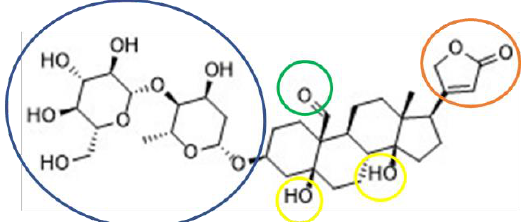
Figure 3. Functional groups in erysimoside: hydroxyl at 5 and 14 (in yellow); oxo at 19 (in green); β - D -glucopyranosyl-(1- > 4)-2,6-dideoxy-4- O- β - D -ribo-hexopyranosyl at 3 (in blue); and furanonyl (butenolide ring) at 20 (in orange).